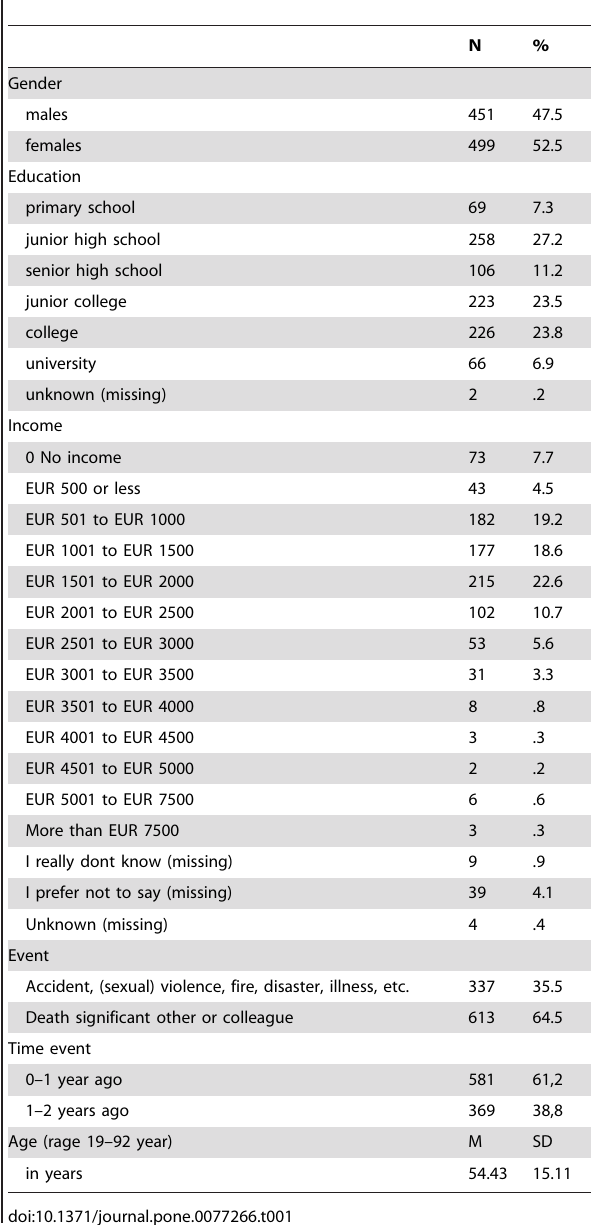
Table 1. Demographic characteristics respondents (N